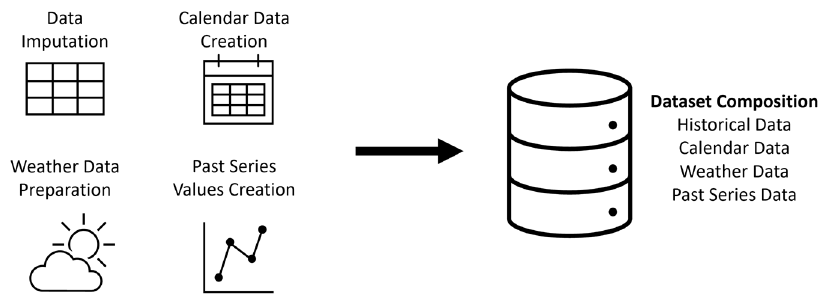
Figure 4. Data preparation steps for dataset formation.